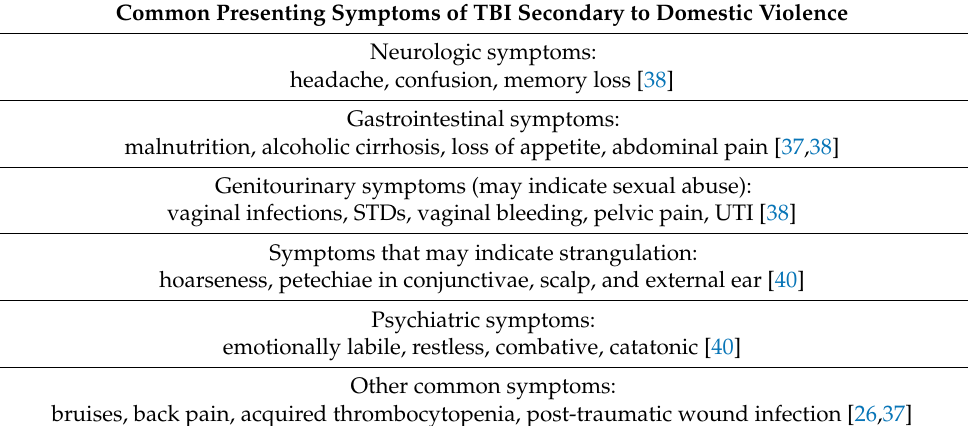
Table 3. Common presenting symptoms of TBI secondary to domestic